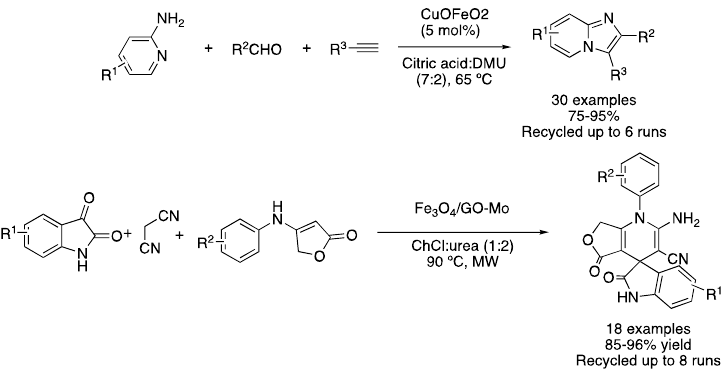
Figure 12. Heterocycle synthesis using heterogeneous catalysts in DESs.